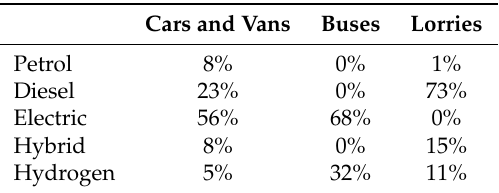
Table 4. Vehicle and fuel distribution in scenario 2030.